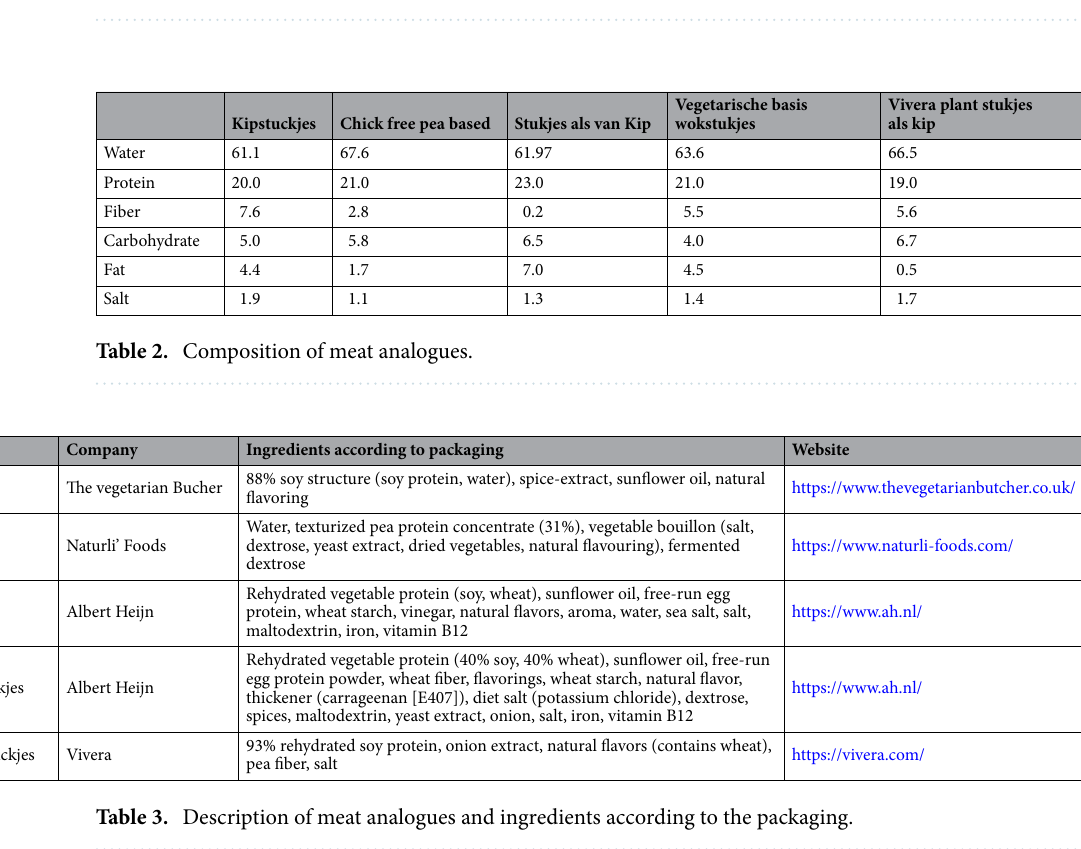
Table 1. Composition of meat and fish.